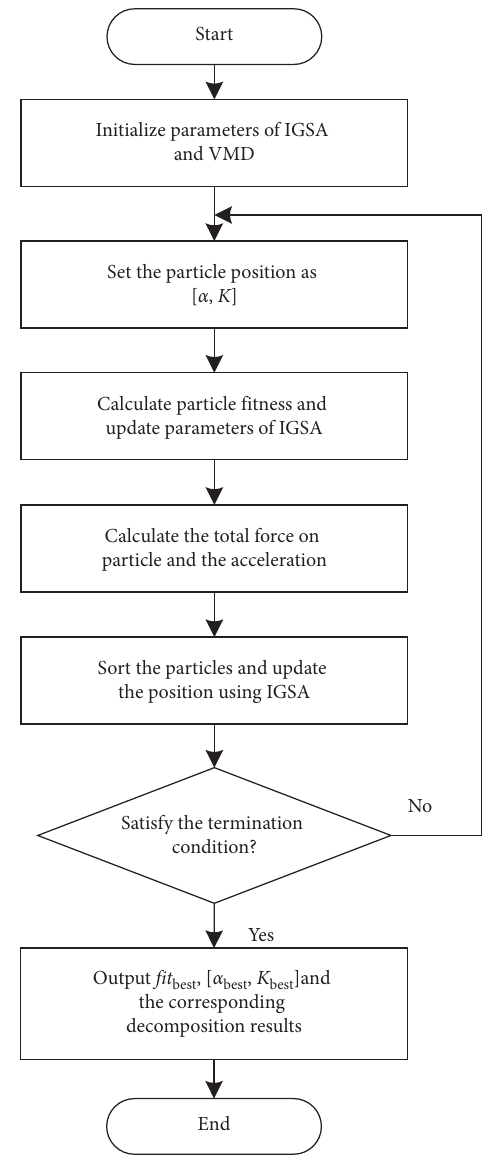
Figure 3: Flowchart of IGSA-VMD.